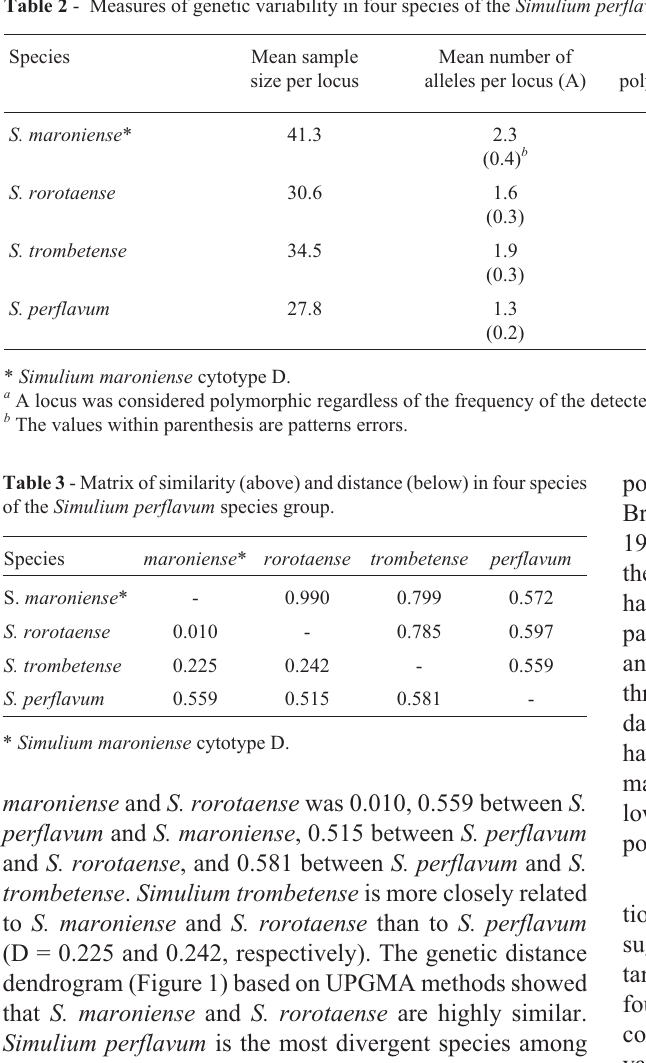
Table 2 - Measures of genetic variability in four species of the Simulium perflavum species group.